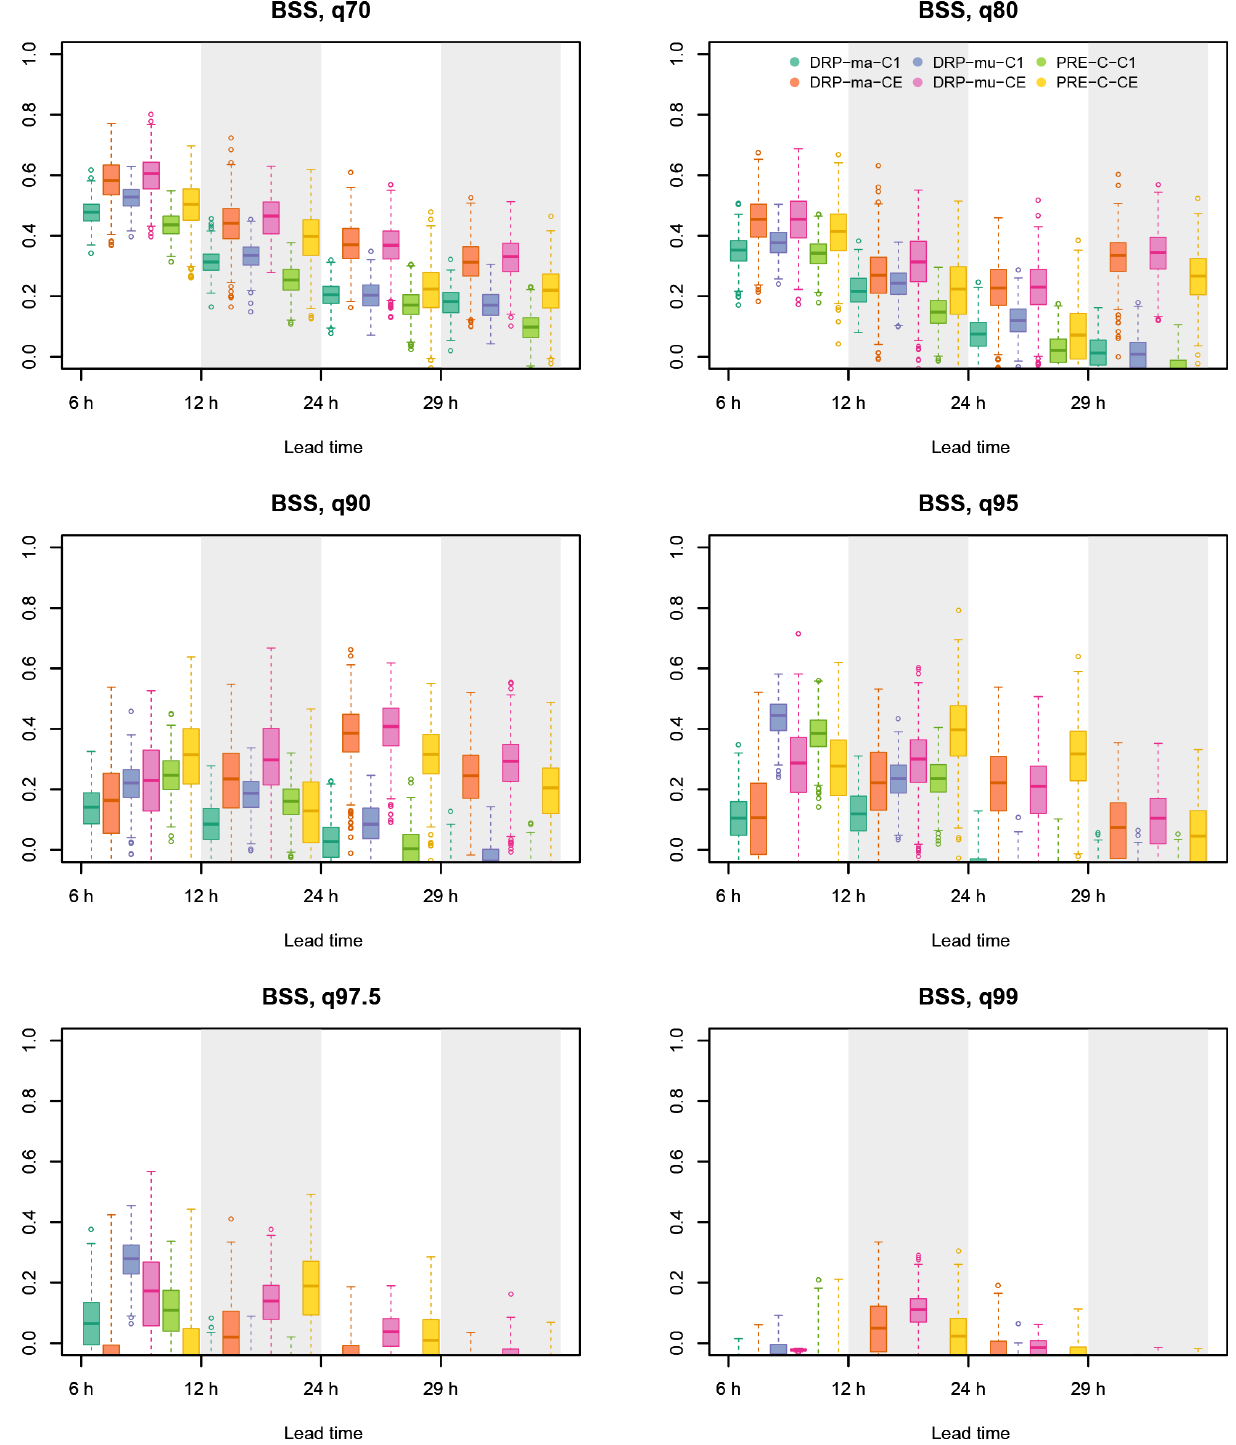
Figure 8. Comparison of BSS in the Emmenmatt catchment for deterministic DRP-ma-C1, DRP-mu-C1 and PRE-C-C1 and probabilistic DRP-ma-CE, DRP-mu-CE and PRE-C-CE as a function of lead time for several threshold quantiles for all events in the investigated period from May until July 2016. A window of 6h was taken for the computations. The box plots represent the sampling uncertainties of the score computations obtained with